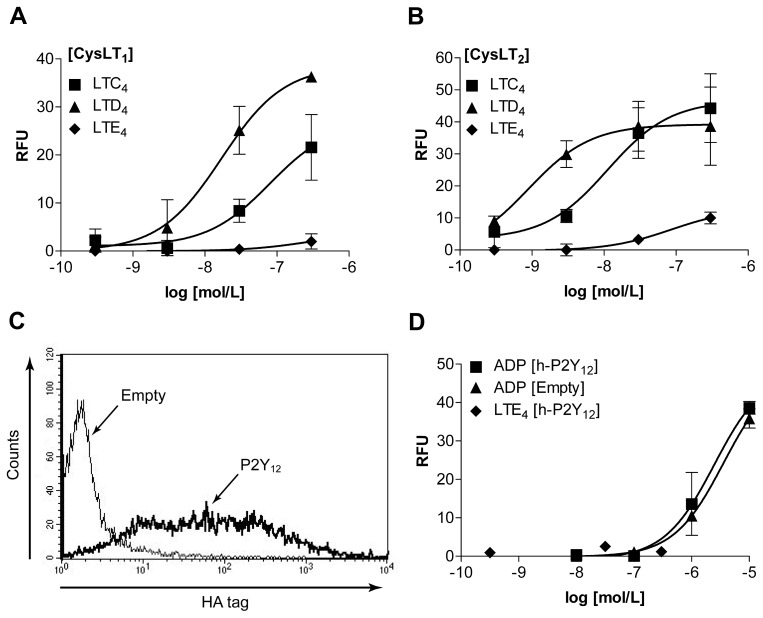
Effect of LTE4 on calcium mobilisation in h-P2Y12 overexpression model.HEK293 cells were transiently transfected with indicated vectors and intracellular responses recorded. (A) [h-CysLT1] and (B) [h-CysLT2] transfectants stimulated with indicated concentrations of LTC4, LTD4 and LTE4. N = 6. (C) Flow cytometry analysis of h-P2Y12 protein surface expression in [h-P2Y12] and [Empty] transfectants using an anti-HA antibody, representative of three experiments. (D) [h-P2Y12] and [Empty] transfectants stimulated with ADP or LTE4, N = 9. Results (A), (B) and (D) represented as peak intracellular calcium response, relative fluorescence units (RFU), mean ± S.E.M.